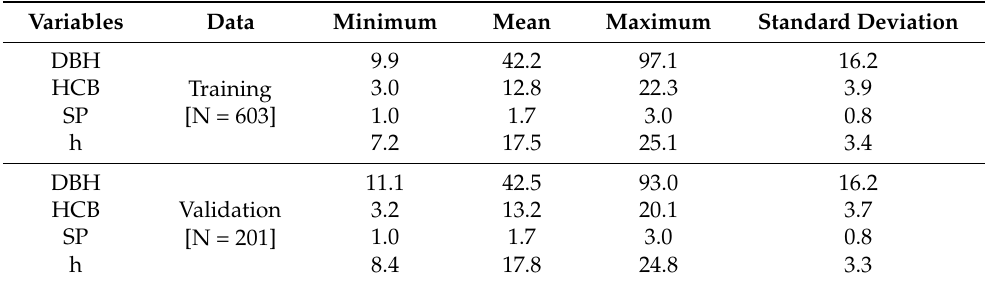
Table 2. Descriptive statistics of dendrometric variable measurements of Brazilian pine.